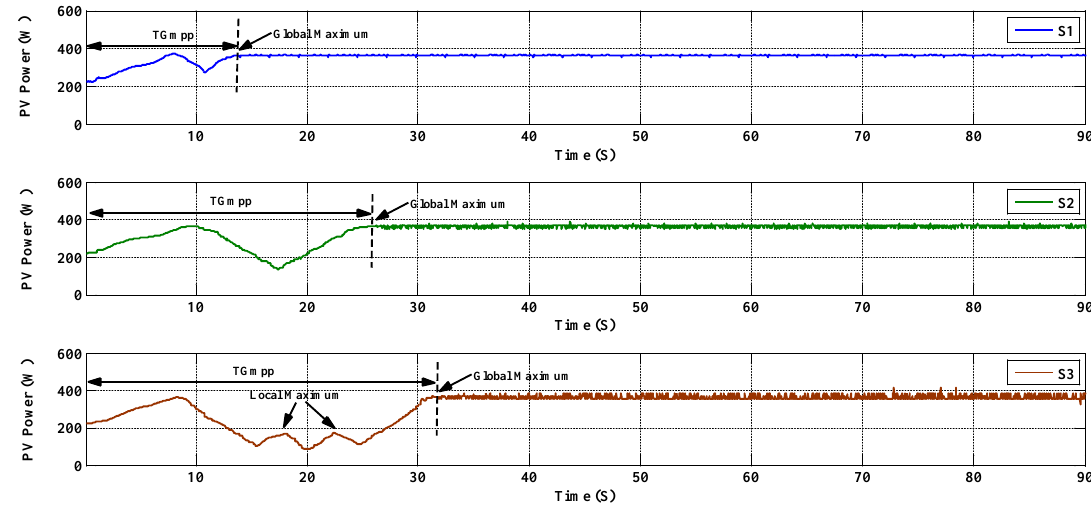
Figure 26. P - V and I - V curves under partial shading conditions.